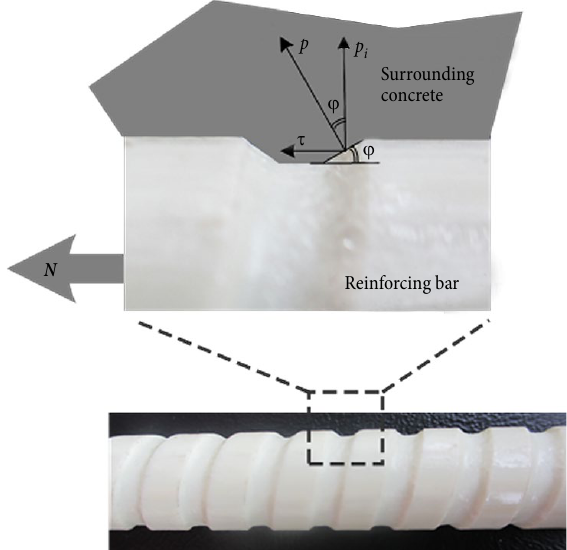
Fig. 3. Carbon FRP sheet for external structural reinforcement (photo form